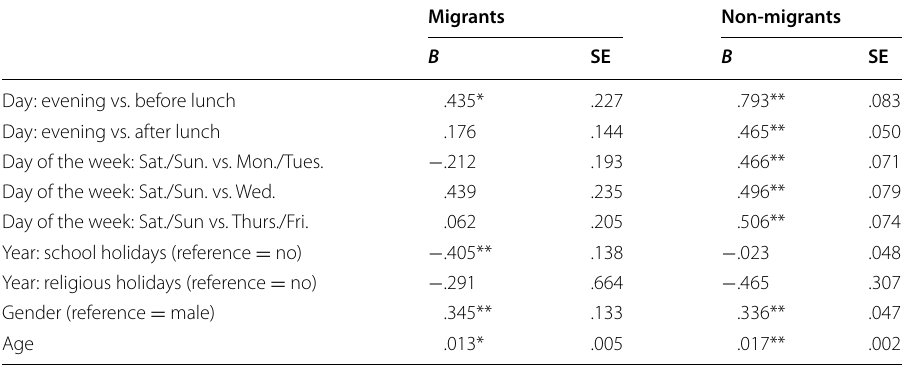
Table 5 Logistic regression to predict contact on first attempt, by migrants and non-